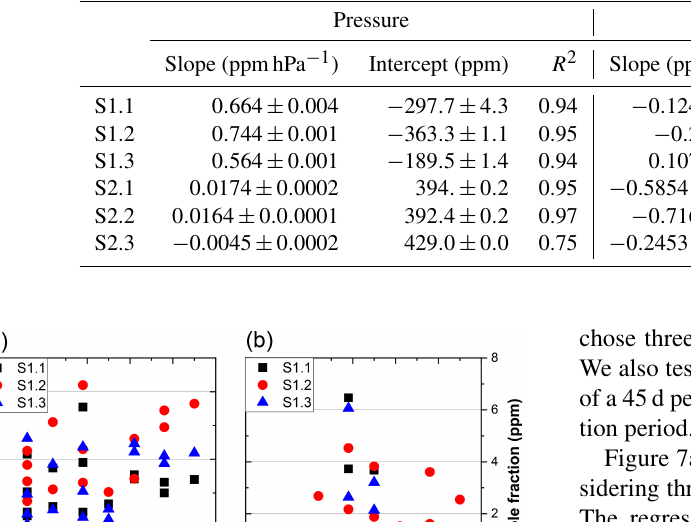
Table 2. Slopes and intercept calculated for CO 2 correction due to temperature and pressure. Sensors S1.1 to S1.3 are type HPP3.1, whereas sensors S2.1 to S2.3 are HPP3.2.